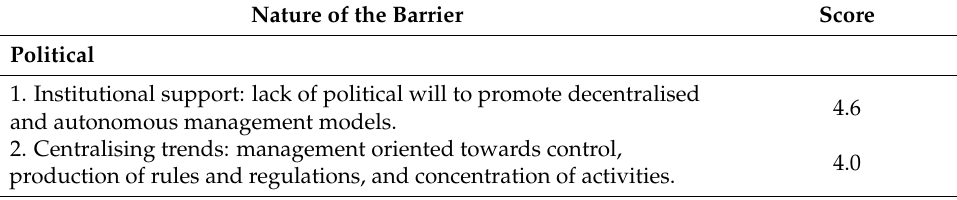
Table 2. Barriers to clinical governance and score according to priority